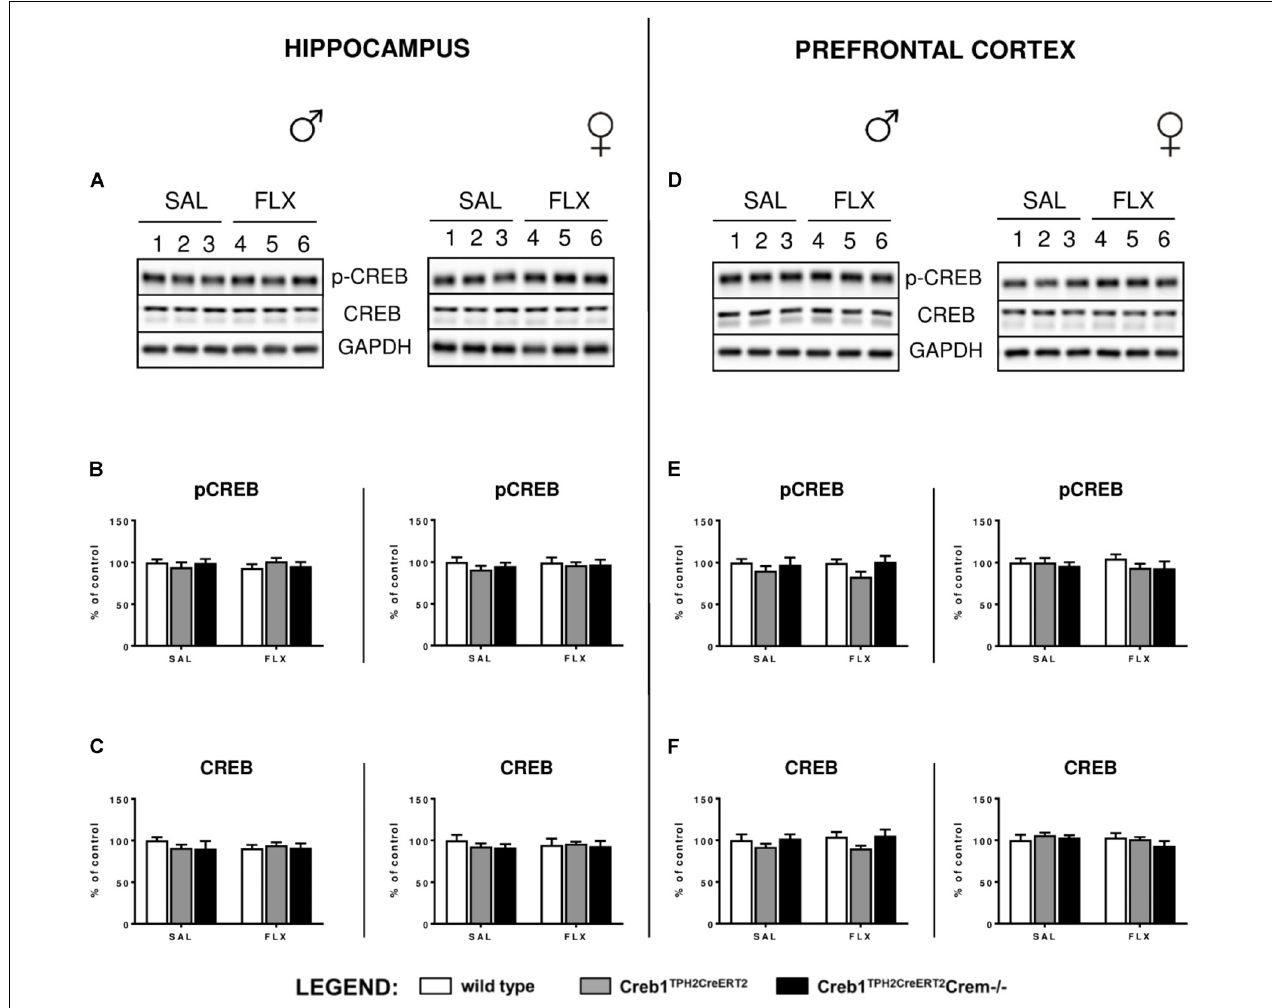
FIGURE 5 | Lack of effect of chronic fluoxetine administration on CREB protein expression and phosphorylation levels in wild-type, Creb1 TPH2Cre and Creb1 TPH2CreERT2 mice. No changes in the protein levels of pCREB and CREB were observed with regard to treatment, genotype, and gender. Western blot analyses of the effects of fluoxetine administration on the protein levels of (B,E) phosphorylation at Ser133 CREB (p-CREB) and (C,F) total CREB in the hippocampus (left panel) and PFC (right panel) of wild-type, Creb1 TPH2CreERT2 , and Creb1 TPH2CreERT2 Crem–/– mice. (A,D) Representative blots of p-CREB,